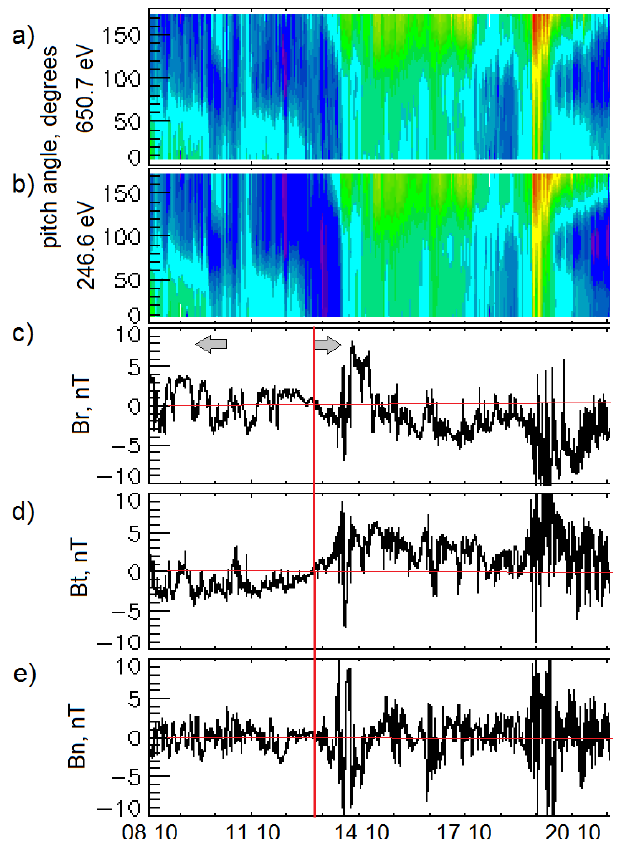
Figure 1. Suprathermal electron pitch angle distribution at 650.7eV (a) and 246.6eV (b) compared with the three IMF com- ponents (c, d, e) measured by STEREO-A in the RTN (Radial Tan- gential Normal) coordinate